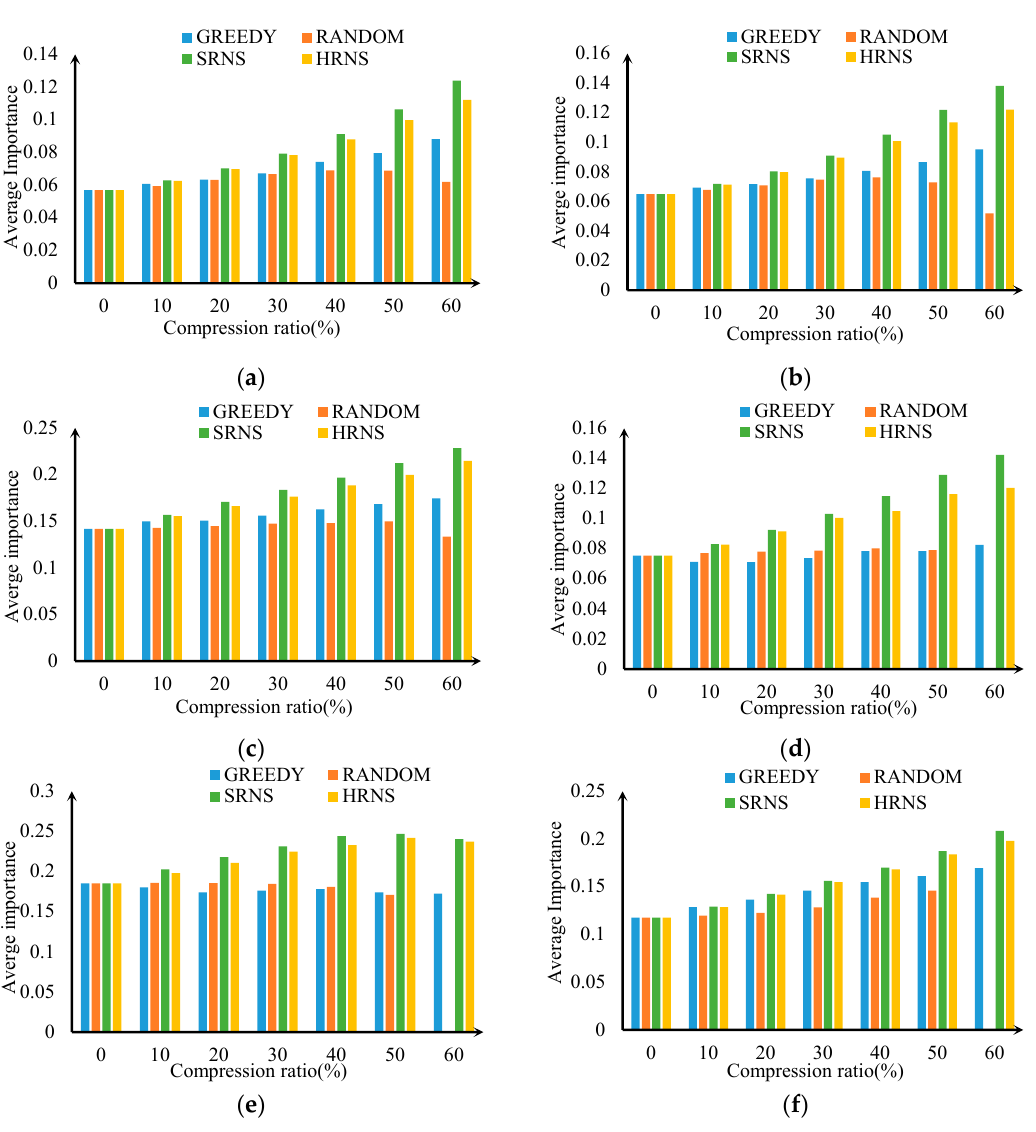
Figure 5. Average node importance as a function of compression ratio. ( a ) 2000-2 dataset. ( b ) 2500-2 dataset. ( c ) Blog dataset. ( d ) Cora dataset. ( e ) Ca-GrQc dataset. ( f ) UCforum dataset.